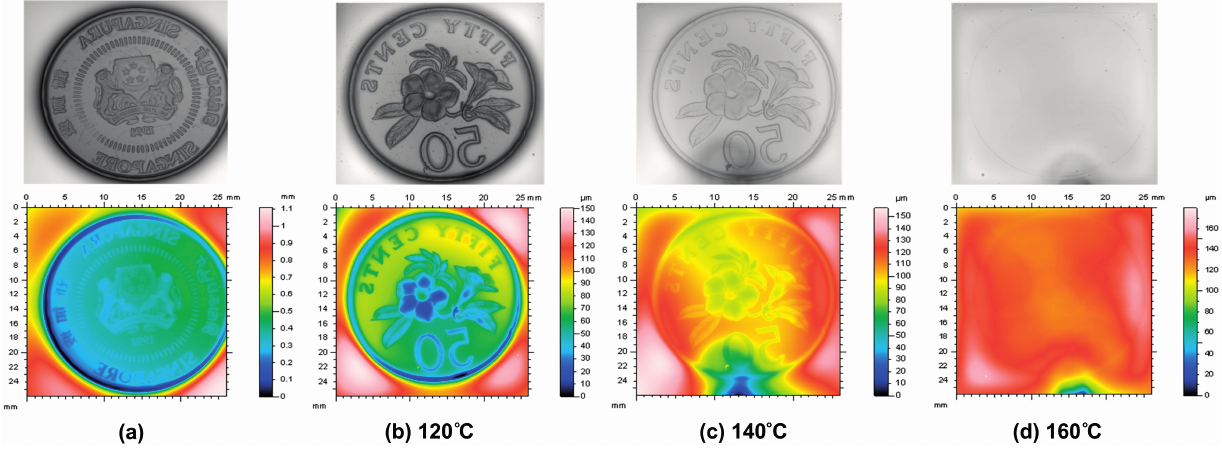
Figure 18. Evolution of surface morphology upon heating in PMMA. Top row: optical image; bottom row: 3-D surface scanning. ( a ) After programming; ( b ) after heating to 120 °C; ( c ) after heating to 140 °C; and ( d ) after heating to 160 °C. Reproduced with permission from Elsevier, 2014